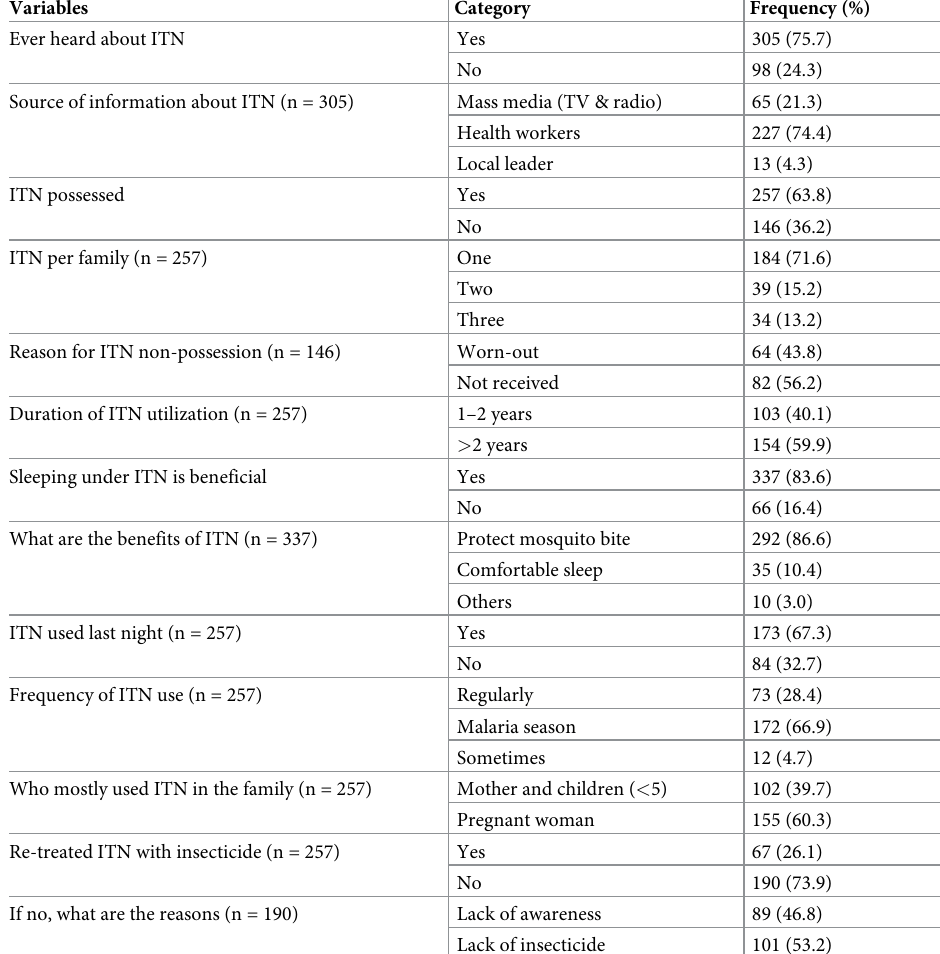
Table 4. The use of ITNs among the respondents ( N = 403).